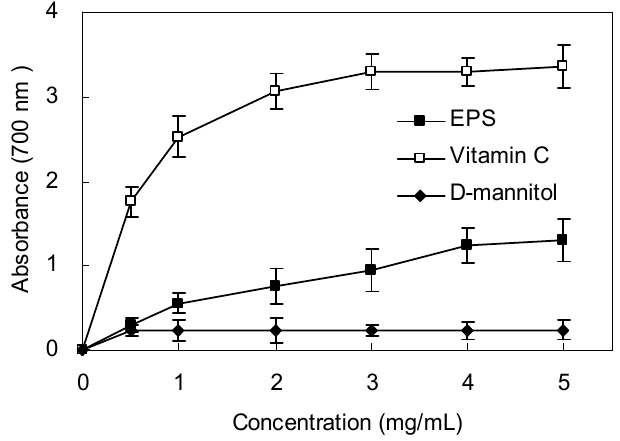
Figure 5. Reducing power of EPS from Bacillus cereus SZ1. Ascorbic acid was used as positive control. Values represent the mean ± S.D. of triplicate samples.